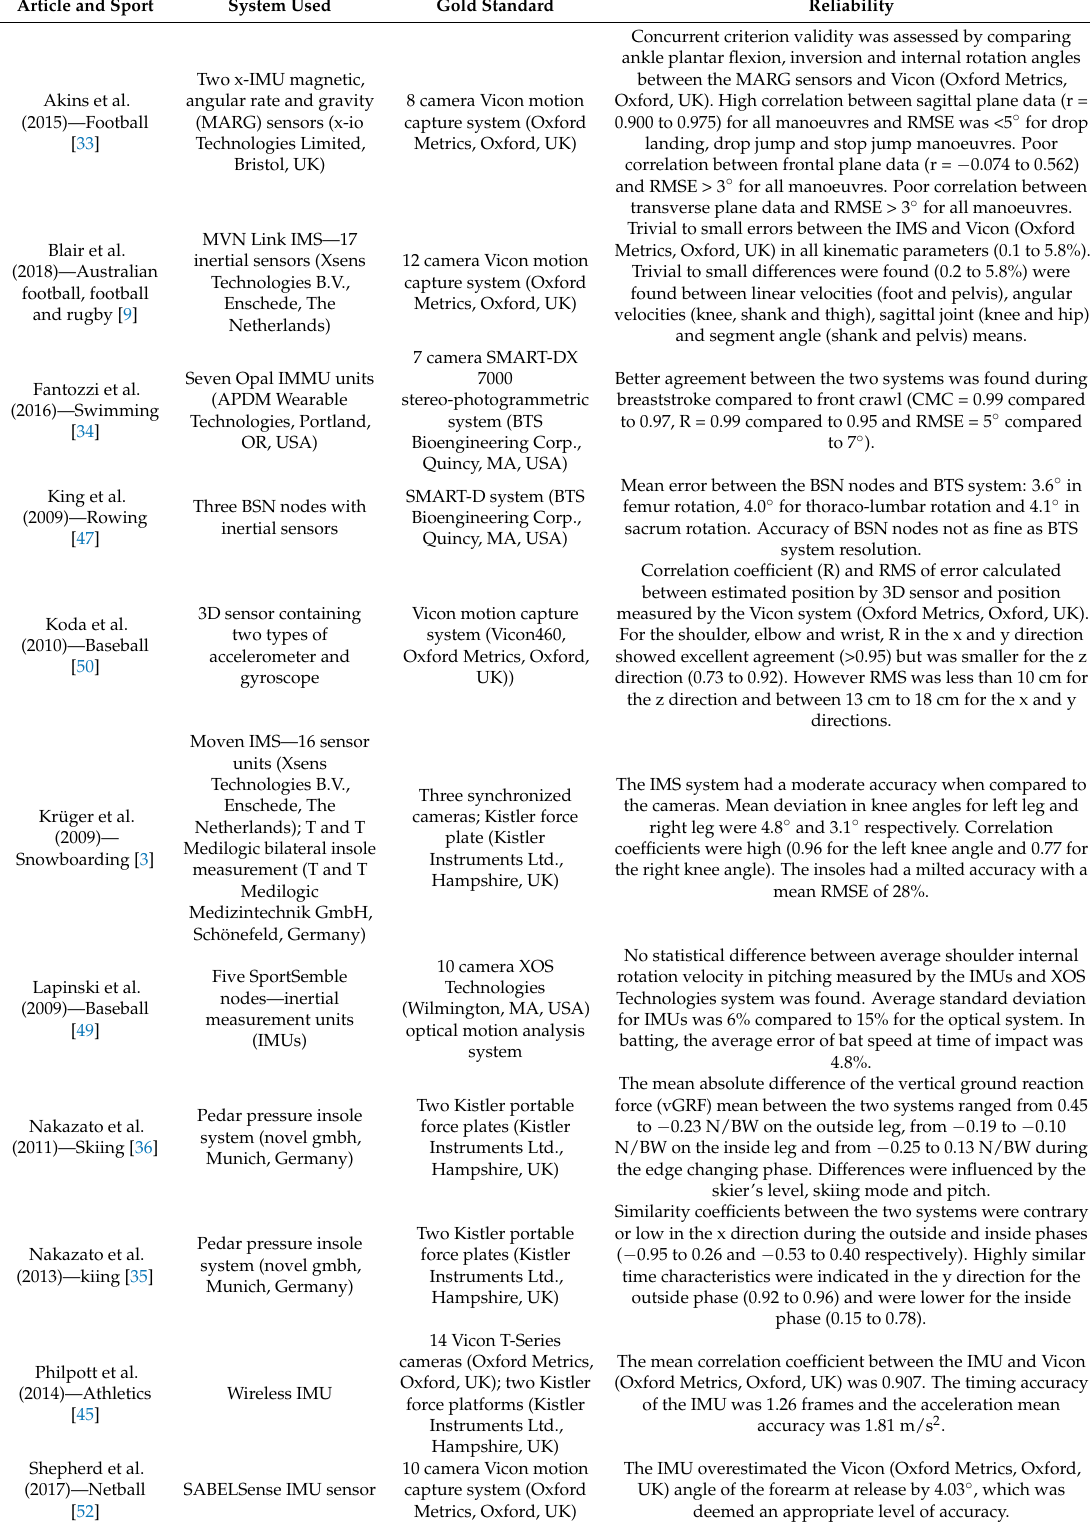
Table 5. Wearable systems compared to a gold-standard